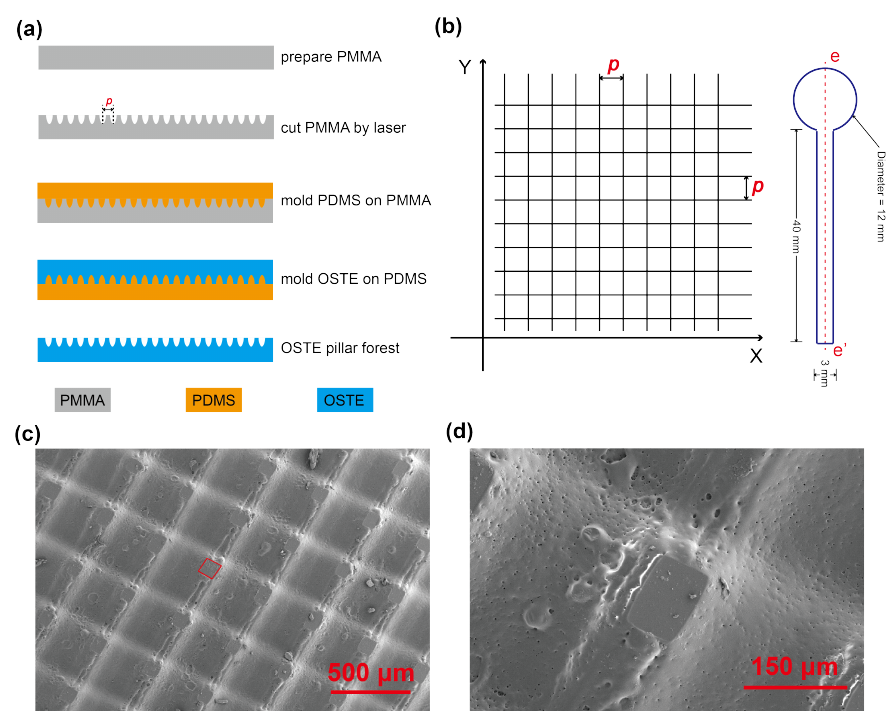
Figure 1. Fabrication and design of OSTE pillar forest. ( a ) The fabrication procedures of OSTE pillar forest: at first, we engraved the PMMA using a laser; then, we used the PMMA to mold PDMS; and after that, we used the PDMS negative to mold OSTE. ( b ) The cutting pattern of the laser on PMMA (left) and the design of the OSTE pillar forest strip (right). The main axis (e-e’) of the OSTE pillar forest strip is along the Y axis. ( c , d ) SEM pictures of OSTE pillar forest.